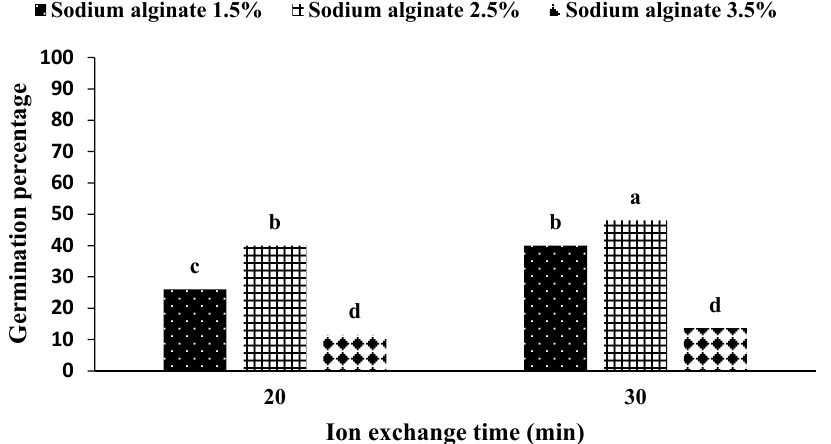
Figure 3. Mean comparison of germination percentages under the influence of ion exchange time and sodium alginate concentration in artificial seeds of S. pennata . Bars with common letters do not differ significantly from each other. p < 0.01 probability level (Duncan’s test).